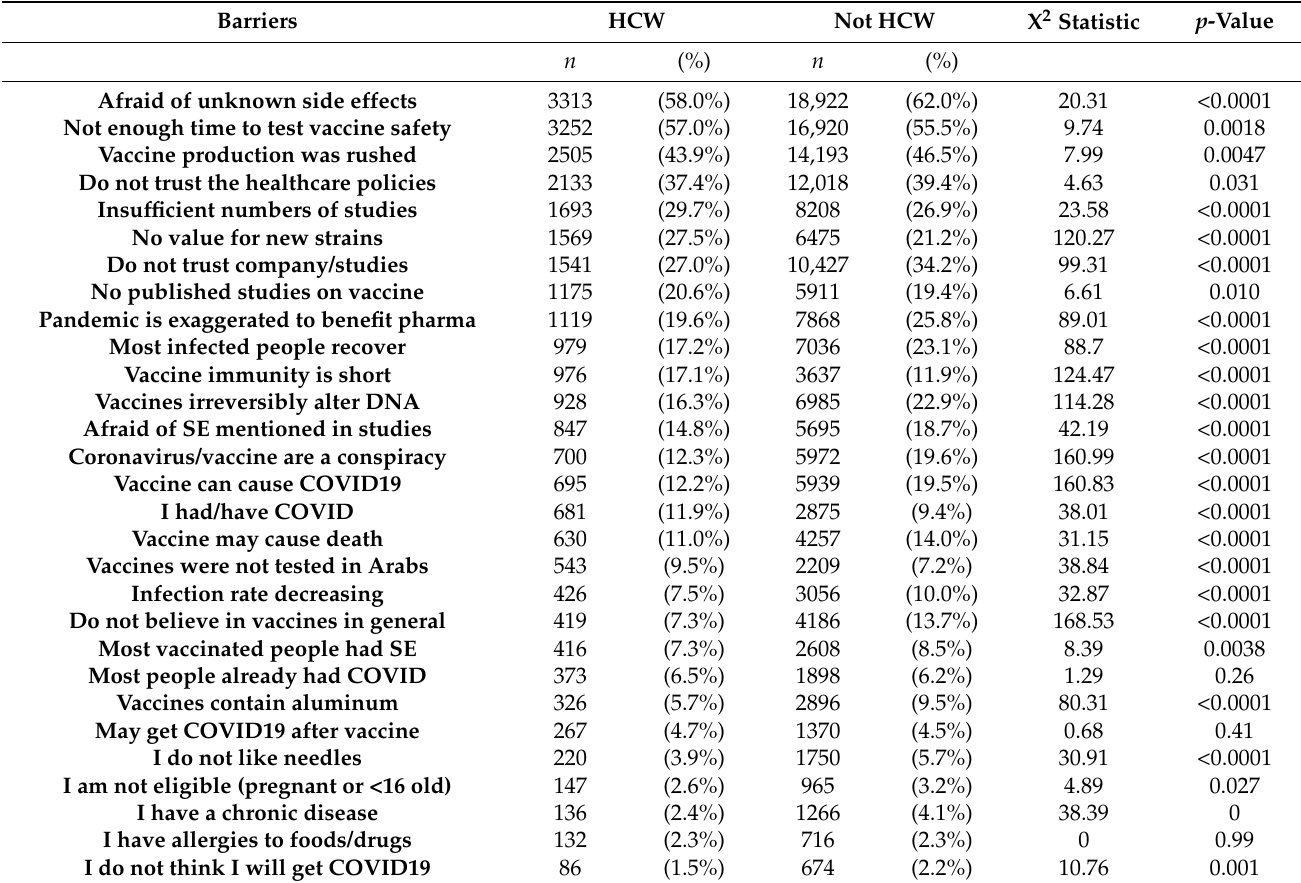
Table 4. Barriers among HCW and non-HCW